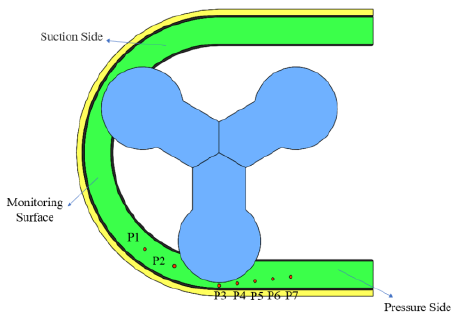
Figure 5. Distribution of monitoring points and monitoring surfaces.